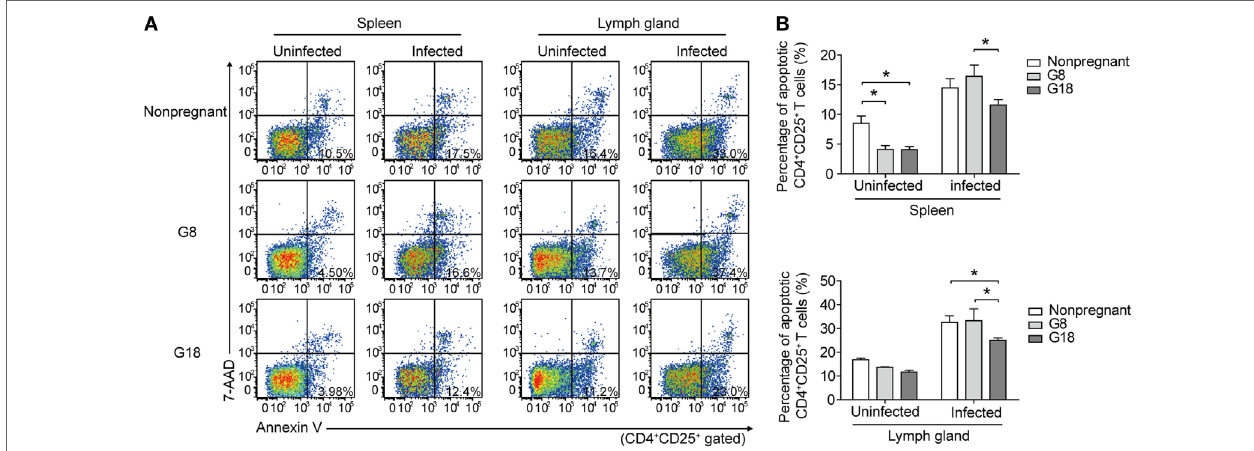
FigUre 3 | Toxoplasma gondii infection in early pregnancy induced higher levels of apoptotic rate of Tregs than that in late pregnancy. (a) The apoptotic rate of CD4 + CD25 + T cells in spleens and inguinal lymph glands of the nonpregnant and pregnant mice (G8, G18) was evaluated by flow cytometry. The gating strategy for the identification of the mouse CD4 + CD25 + T cell population is shown in Figure S1A in Supplementary Material. CD4 + CD25 + T cells in early apoptosis (Annexin + 7AAD − ) were in the lower right quadrant. (B) The apoptotic rate of CD4 + CD25 + T cells in spleens and inguinal lymph glands of the nonpregnant and pregnant mice (G8, G18) with T. gondii tachyzoite or PBS injection, respectively. Data are expressed as the means ± SD of five mice for each group from one experiment representative of two independent experiments. Significance was determined by one-way ANOVA. * P <